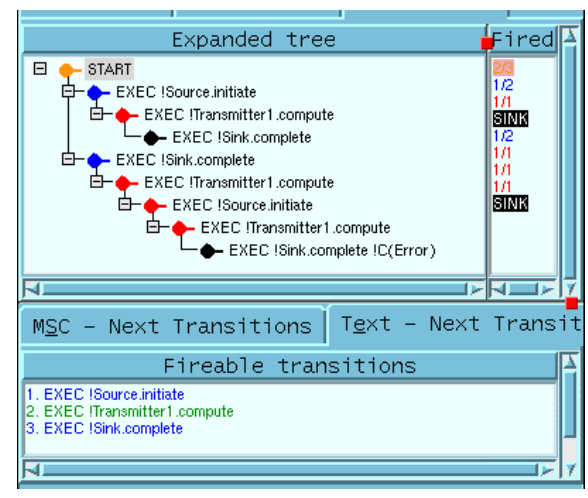
Figure 6 Screen-shot of the OCIS simulator of CADP ( chain benchmark, n = 1). Table 1 Results of the experiments using TLM.open